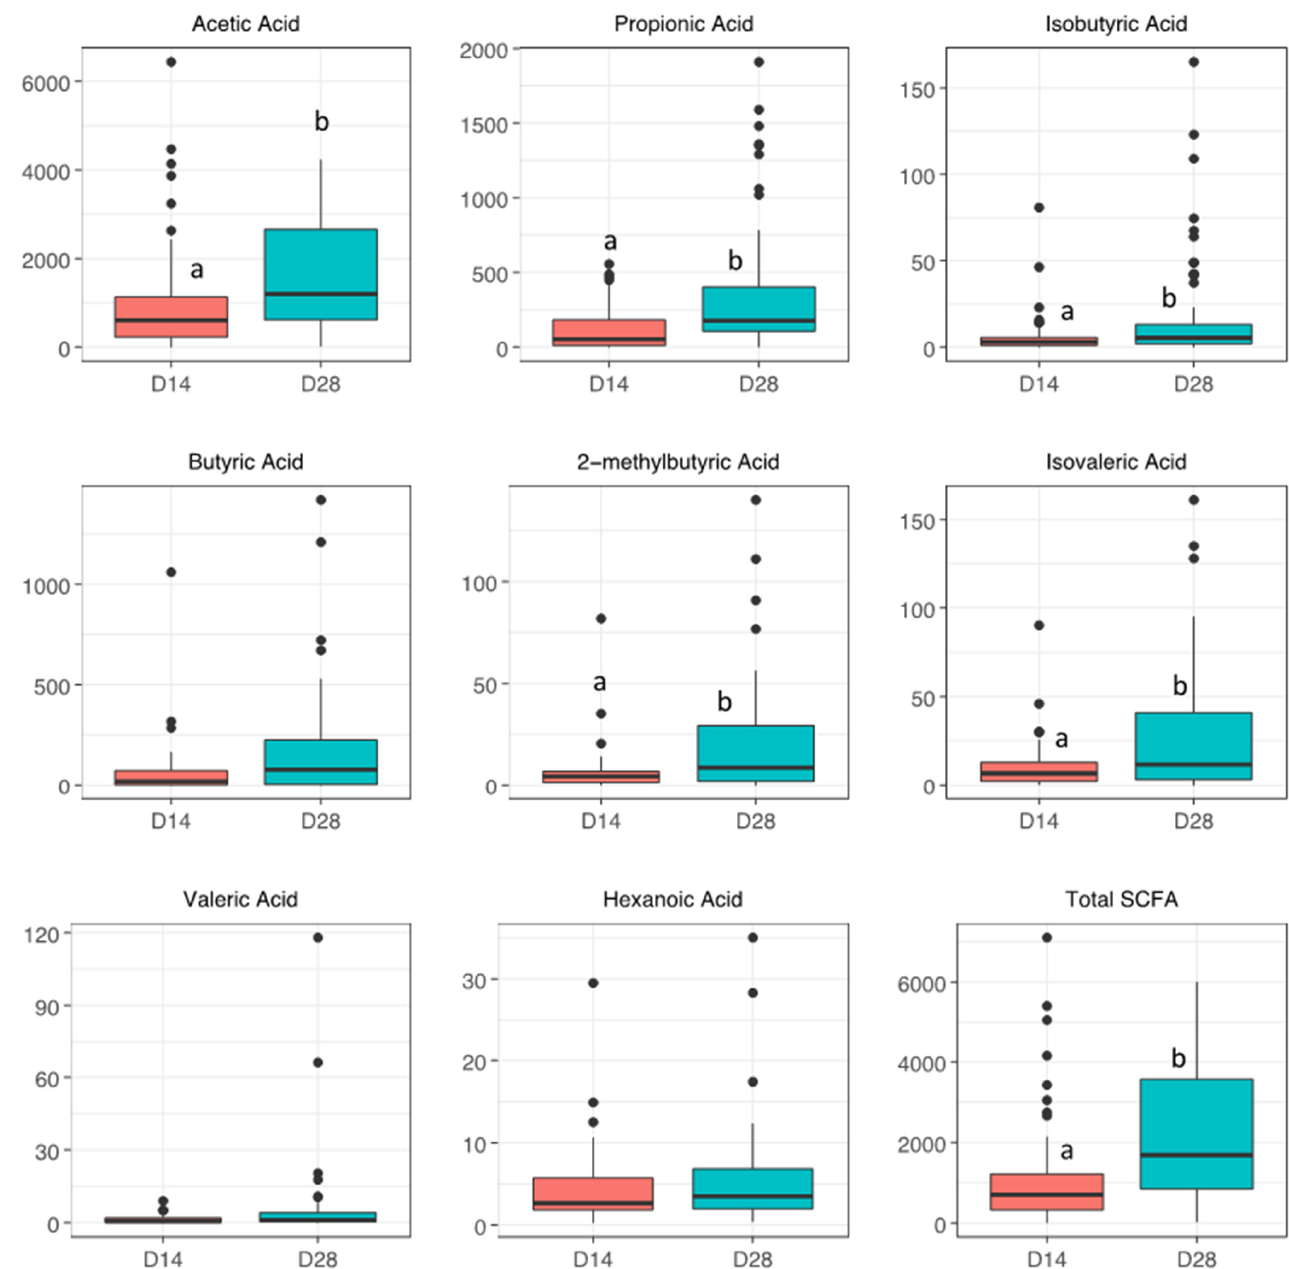
Figure 2. Short-chain fatty acid levels (ng/g) in infant stool samples on days 14 and 28. Boxplots show distribution of SCFAs on days 14 and day 28. Wilcoxon tests were performed to test for statistical significance. Labeled points without a common letter are significantly different ( p < 0.05).